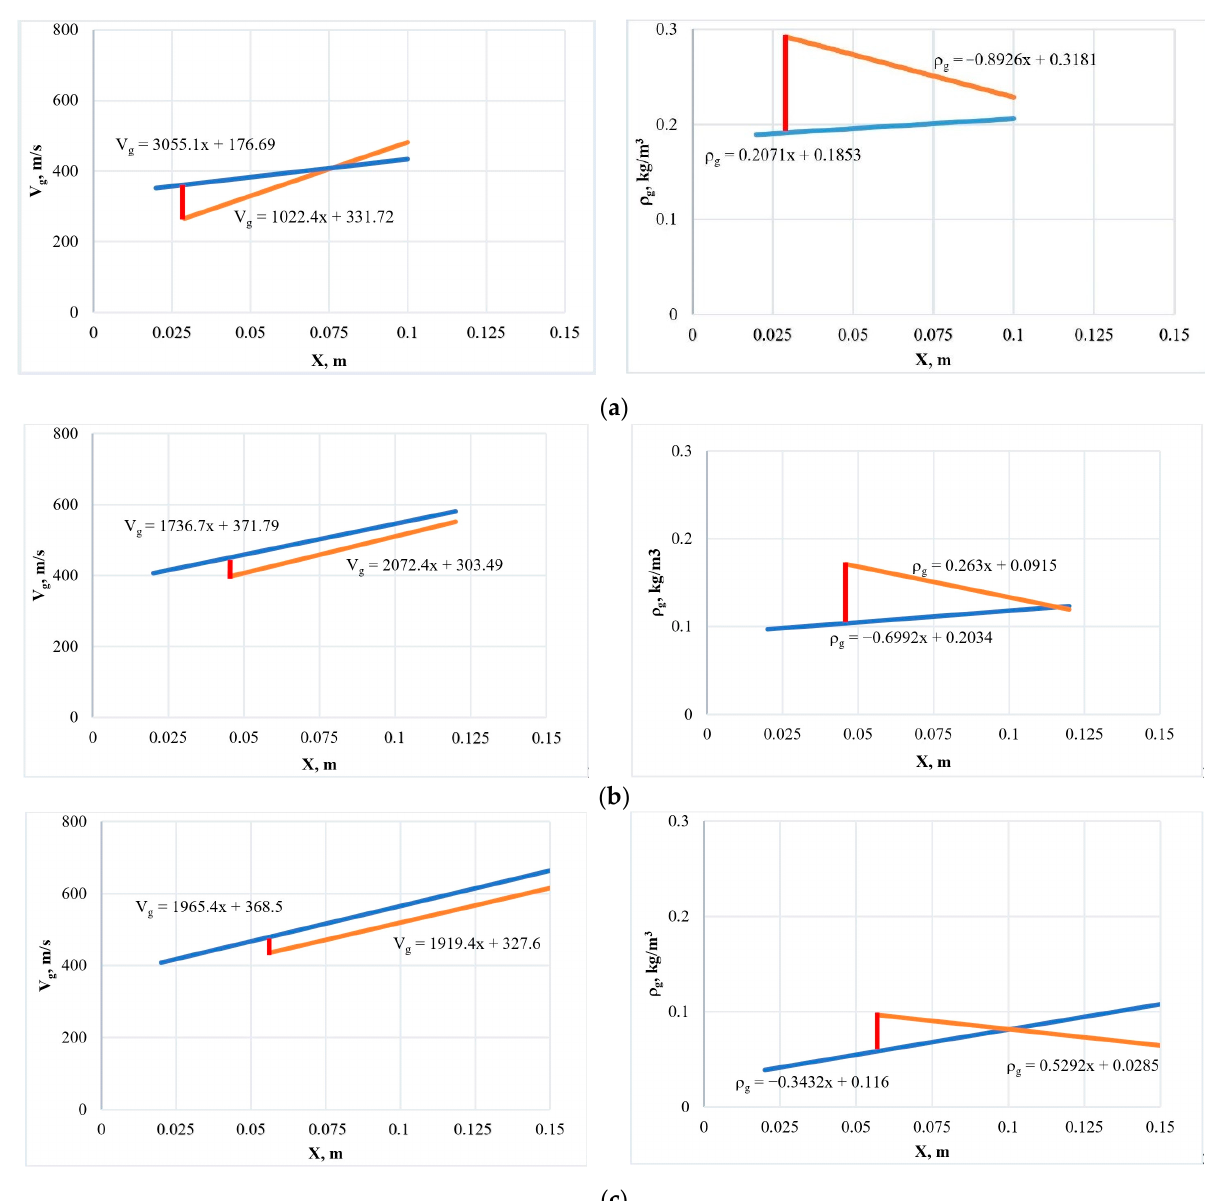
Figure 4. Distribution of velocity (left) and density (right) of the gas phase along the trajectory of the droplets: blue lines-parameters without shock wave; red lines-parameters behind the oblique shock wave. ( a ) nozzle 1, ( b ) nozzle 2, ( c ) nozzle